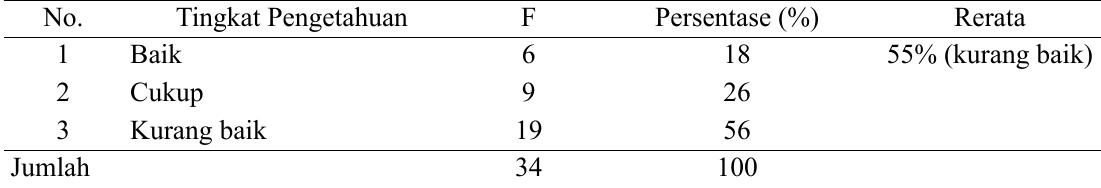
Tabel 6. Distribusi frekuensi pengetahuan (evaluasi) lansia tentang nutrisi di Posyandu lansia